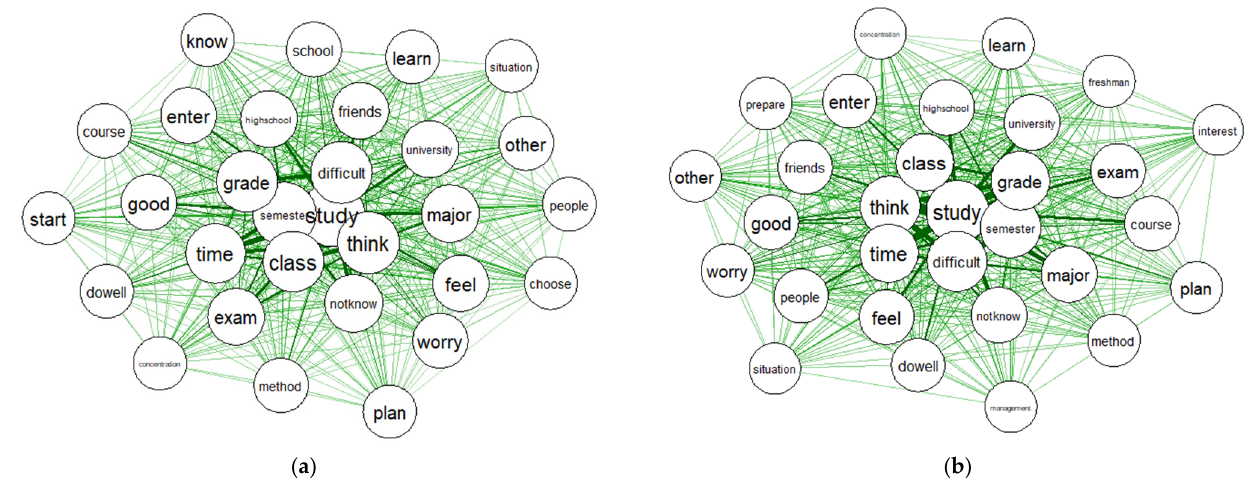
Figure 3. ( a ) Centrality of the top 30 keywords for the HSS track; ( b ) Centrality of the top 30 keywords for the STEM track.